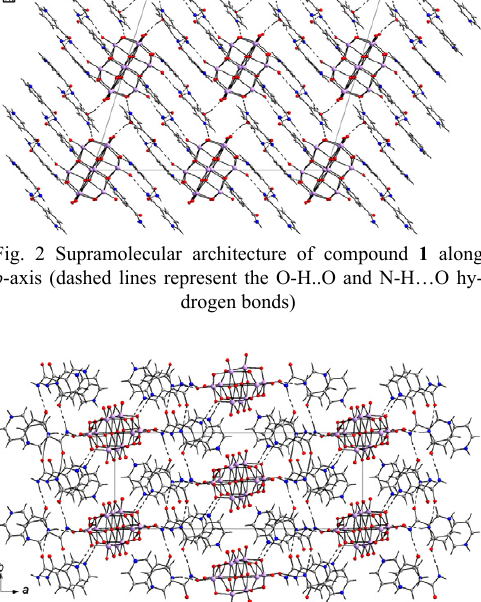
Fig. 3 The packing structure of compound 1 derived from π-π interactions and hydrogen bonds along c